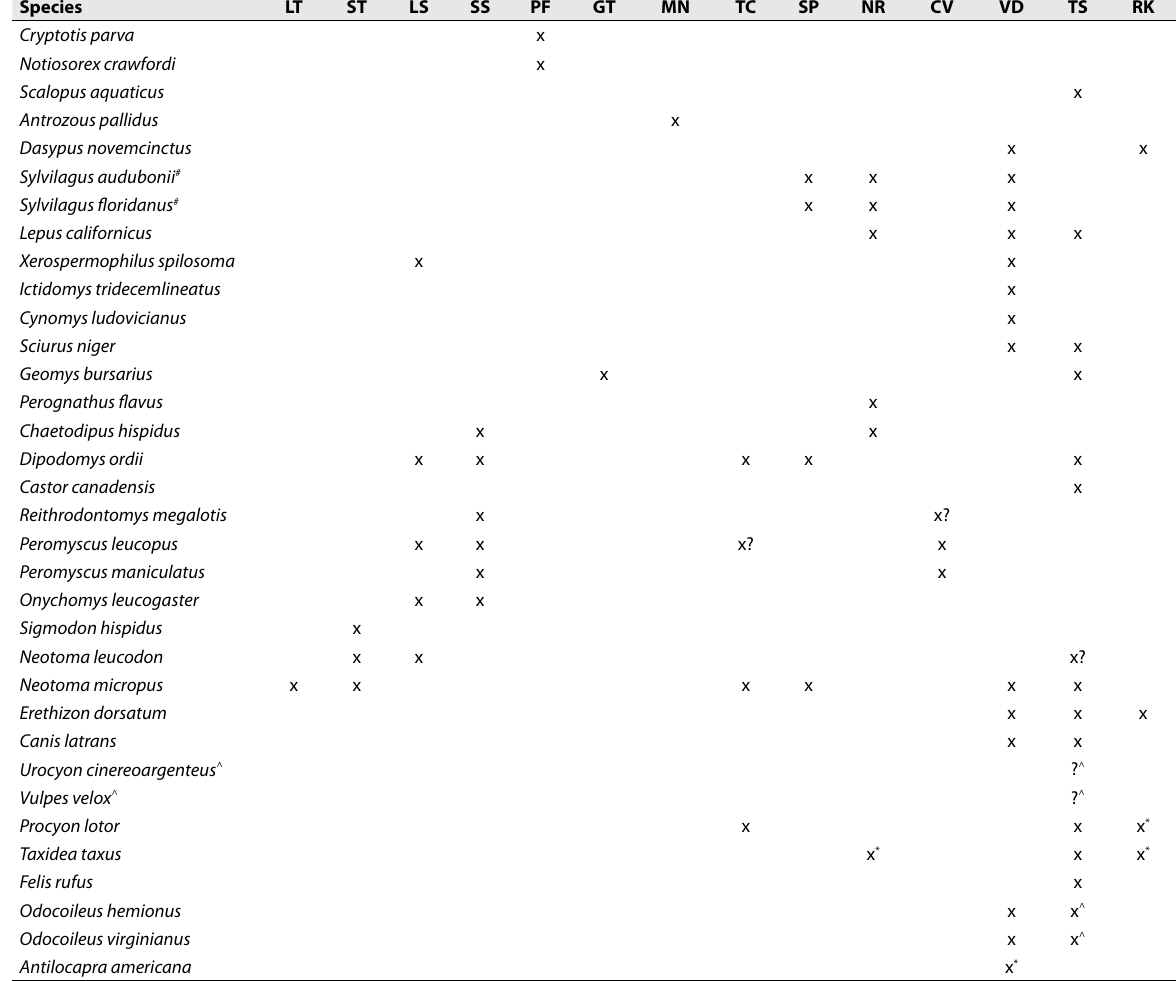
Table 2. Mammalian species detected in Lake Meredith National Recreation Area and Alibates Flint Quarries National Monument by specific methods in the present study, 2002–2003. Legend: (LT) large Tomahawk trap, (ST) small tomahawk trap, (LS) large Sherman trap, (SS) small Sherman trap, (PF) pitfall traps, (GT) gopher traps, (MN) mist-nets, (TC) Trailmaster™ cameras, (SP) spotlight surveys, (NR) night road surveys, (CV) coverboards, (VD) visual daytime encounters, (TS) tracks and signs, (RK) roadkilled or found dead, (*) recorded outside the protected areas; (#) difficult to distinguish between the